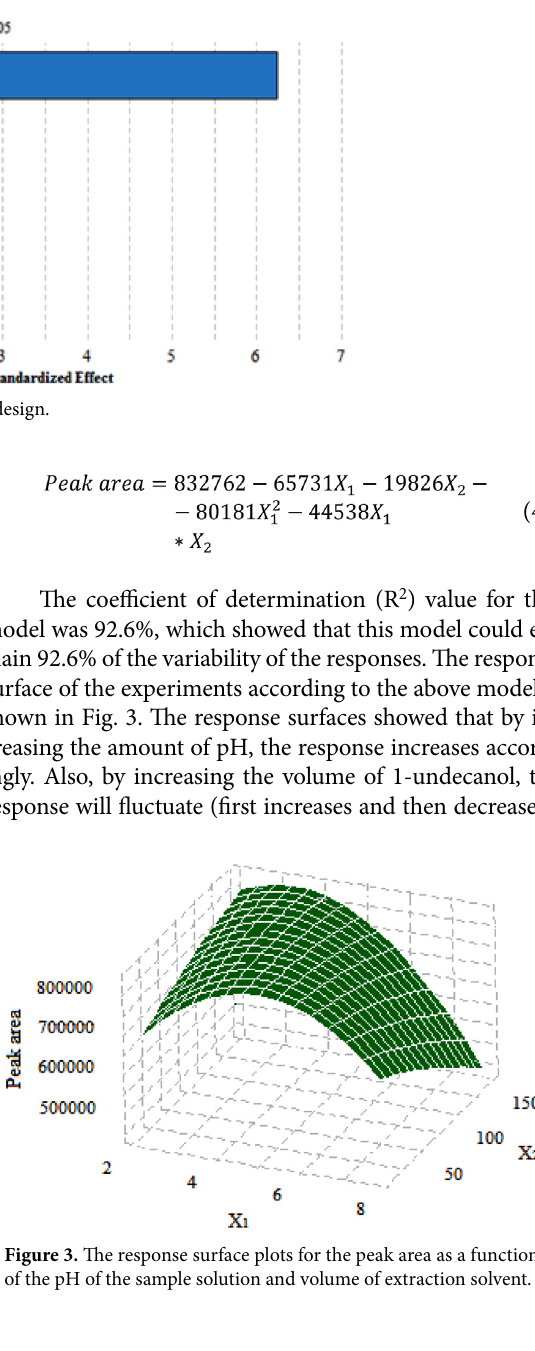
Table 1 . Analysis of Variance (ANOVA) of CCD